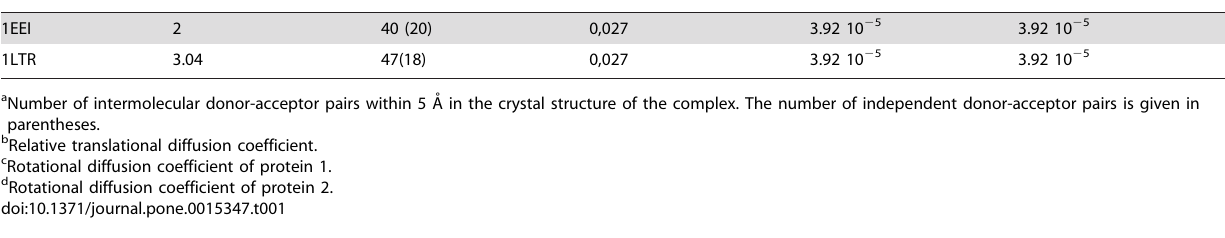
Table 1. Structural parameters for the CtxB 5 and LTB 5 complexes.